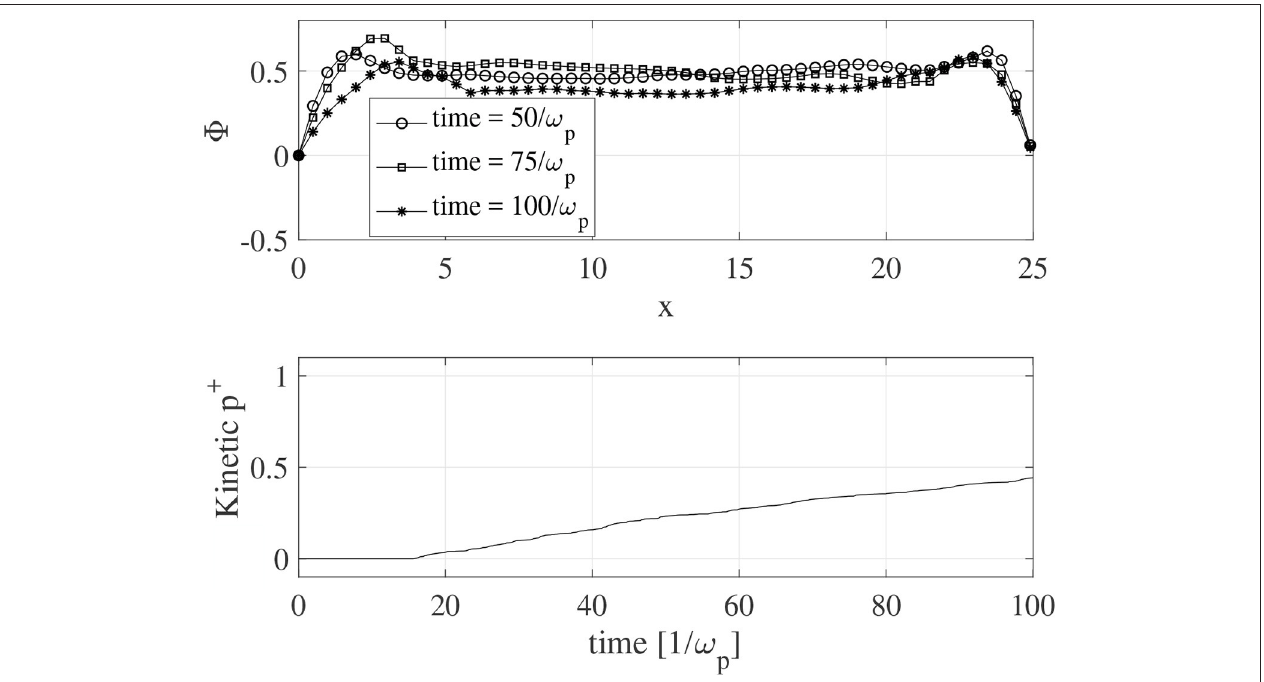
FIGURE 9 | (Top) The electrostatic potential in the simulation domain at three time steps: t ω p (Bottom) The ratio of kinetic ions during the sheath